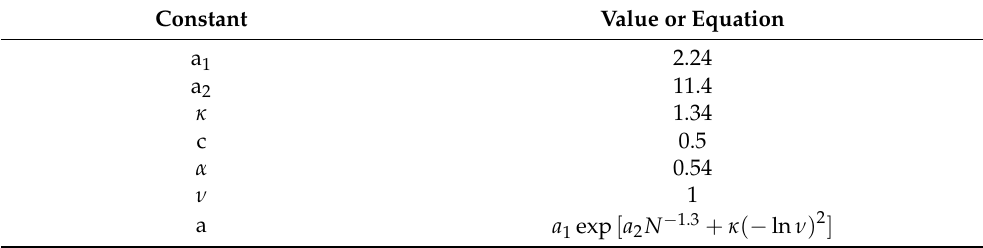
Table 2. Constants for the Weibull distribution, k =